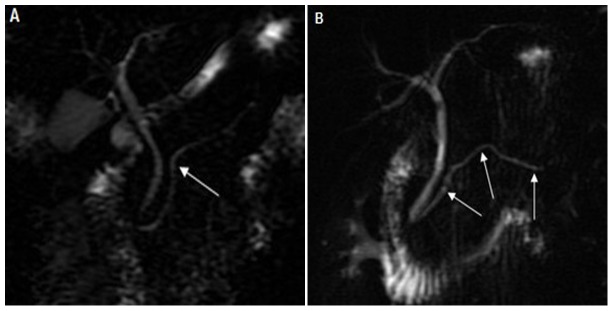
Magnetic resonance cholangiopancreatography.(A) A 42-year-old male with a normal pancreas. The visualization of the main pancreatic duct was good (arrow). (B) A 34-year-old male with edematous acute pancreatitis. The Acute Physiology And Chronic Healthy Evaluation II score was 4, and the magnetic resonance severity index was 2. The main pancreatic duct was of normal diameter. The visualization of the three segments of the main pancreatic duct was good (arrows).